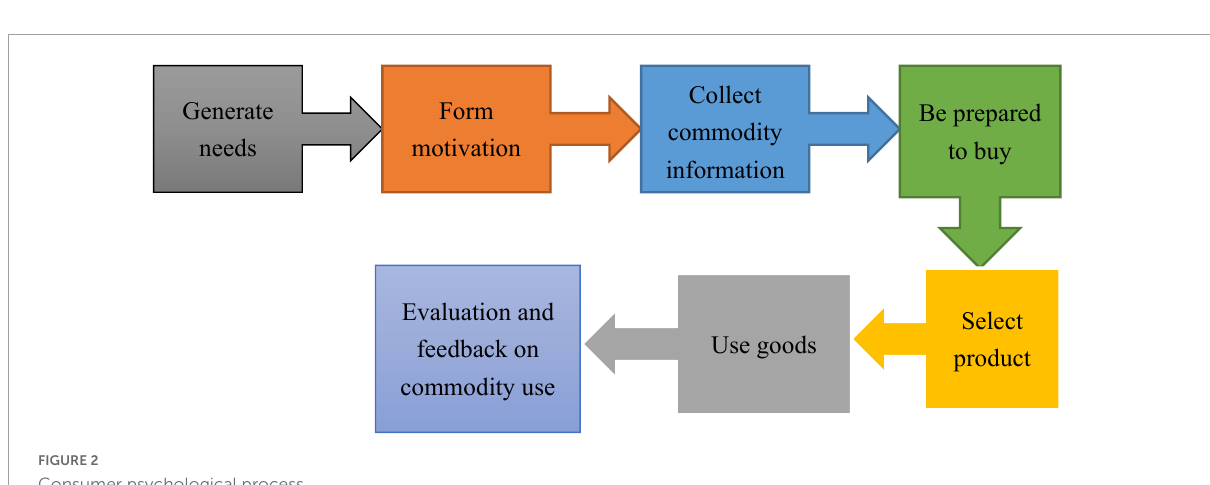
FIGURE1 Consumer psychology.